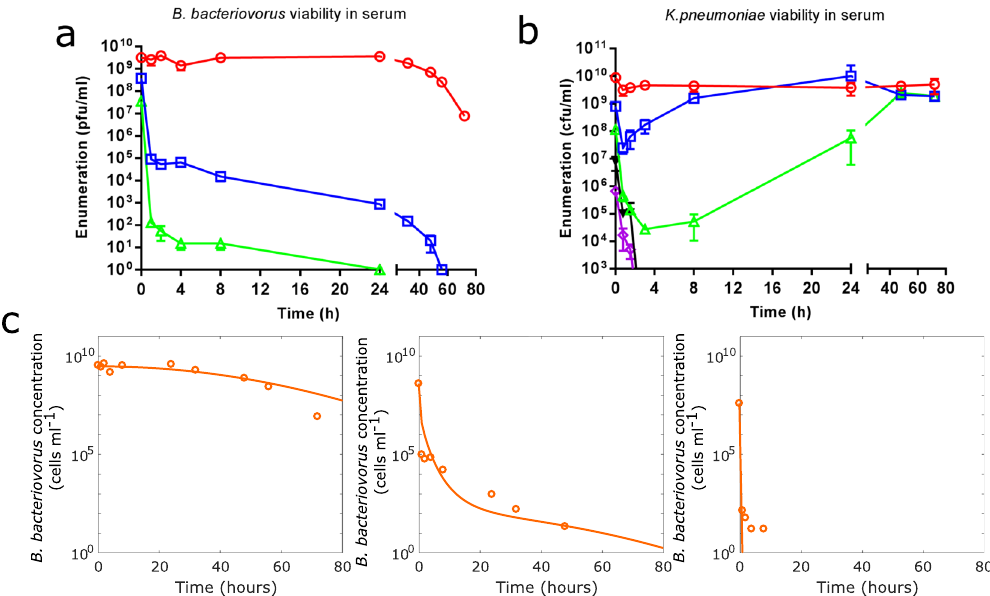
Figure 4. ( a ) Reduction of B. bacteriovorus HD100 by whole human serum. A serially diluted preparation of B. bacteriovorus HD100 was inoculated into whole human serum and viability measured over a 72 h period. ( b ) Reduction of K. pneumoniae concentration by whole human serum. A serially diluted preparation of K. pneumoniae was inoculated into whole human serum and viability measured over a 72 h period by Miles and Misra. ( c ) Model simulations of B. bacteriovorus reduction in human serum for three different initial conditions. Solid line show simulation result whilst the circles show the experimental results (replicated from panel a). Parameter values are given in Supplementary Table S2, in the supplementary